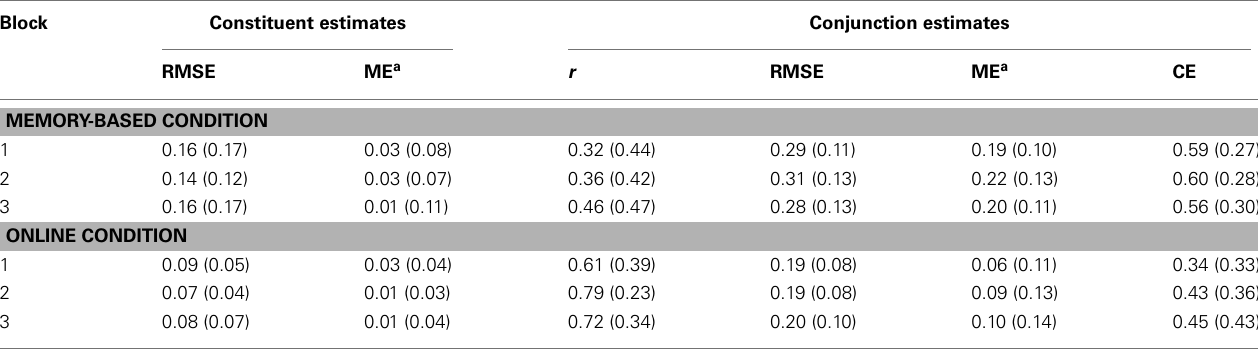
Table 2 |Accuracy of participants’ probability judgments in Experiment 2.